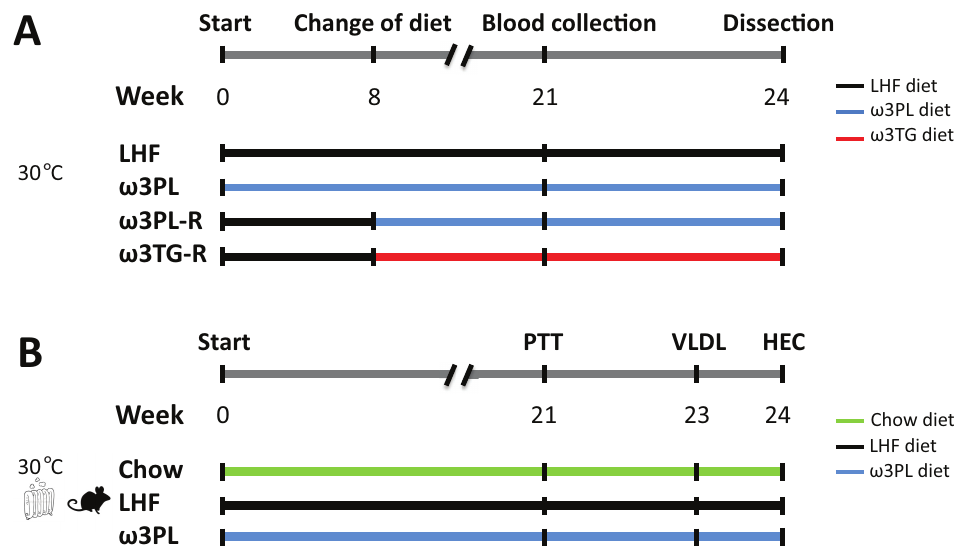
Figure 1. Overview of the experimental setup. ( A ) Four groups of mice ( n = 8) housed in a ther- moneutral environment (~30 ◦ C) were used: (i) the control LHF group, which was fed a lard-based high-fat diet (i.e., LHF diet) for 24 weeks; (ii) ω 3PL group fed a LHF-based diet supplemented with omega-3 PUFAs as PLs in the form of krill oil (i.e., ω 3PL diet) for the duration of the experiment (i.e., “preventive” approach); (iii) ω 3PL-R group fed the LHF diet for the first eight weeks and then from the ninth week on the ω 3PL diet until the end of the experiment (i.e., “reverse” approach; marked with the letter “R” at the end of the group name); and (iv) ω 3TG-R group fed the LHF diet for the first 8 weeks and then from the ninth week on the LHF-based diet supplemented with omega-3 PUFAs in the form of a concentrate of re-esterified TAGs (i.e., ω 3TG diet) until the end of the experiment. ( B ) Three groups of mice ( n = 8) housed in a thermoneutral environment (~30 ◦ C) were used: (i) Chow group, in which mice were fed a standard low-fat diet and served as lean controls; (ii) the control LHF group, which was fed a lard-based high-fat diet (i.e., LHF diet) for 24 weeks; and (iii) ω 3PL group fed the ω 3PL diet for the duration of the experiment. Further details in Section 2.2. PTT, pyruvate tolerance test; VLDL, liver VLDL-TAGs secretion test; HEC, hyperinsulinemic-euglycemic